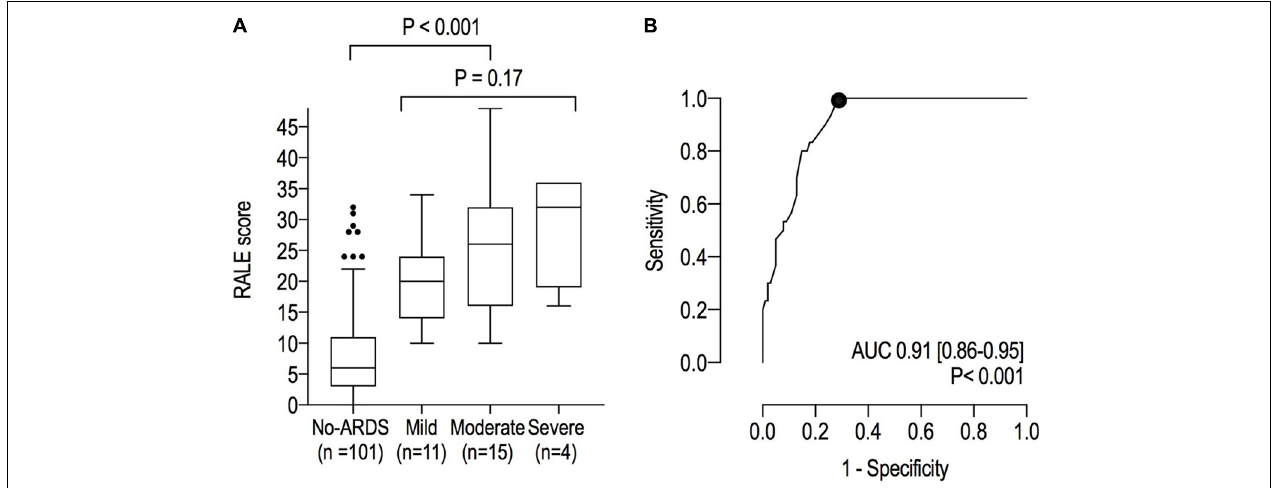
FIGURE 3 | (A) RALE scores in patients with ARDS and those without ARDS; (B) Receiver Operating Characteristic curves for ARDS. The dot represents the optimal cutoff.